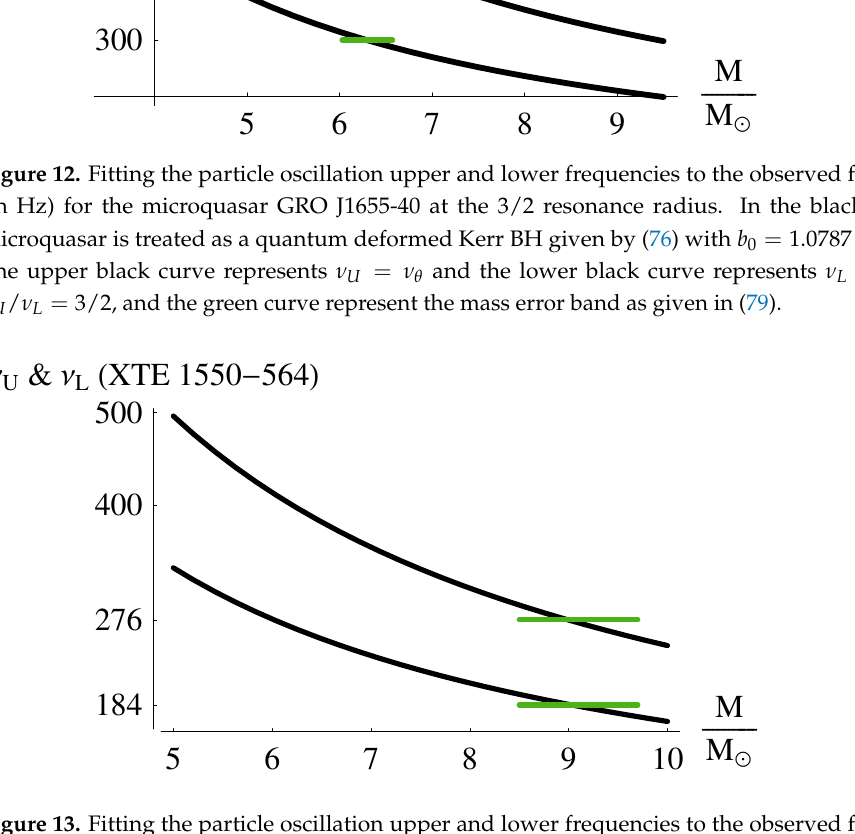
Figure 13. Fitting the particle oscillation upper and lower frequencies to the observed frequencies (in Hz) for the microquasar XTE J1550-564 at the 3/2 resonance radius. In the black plots the microquasar is treated as a quantum deformed Kerr BH given by (76) with b 0 = 1.4825i (i 2 = − 1). The upper black curve represents ν U = ν θ and the lower black curve represents ν L = ν r with ν U / ν L = 3/2, and the green curve represent the mass error band as given in